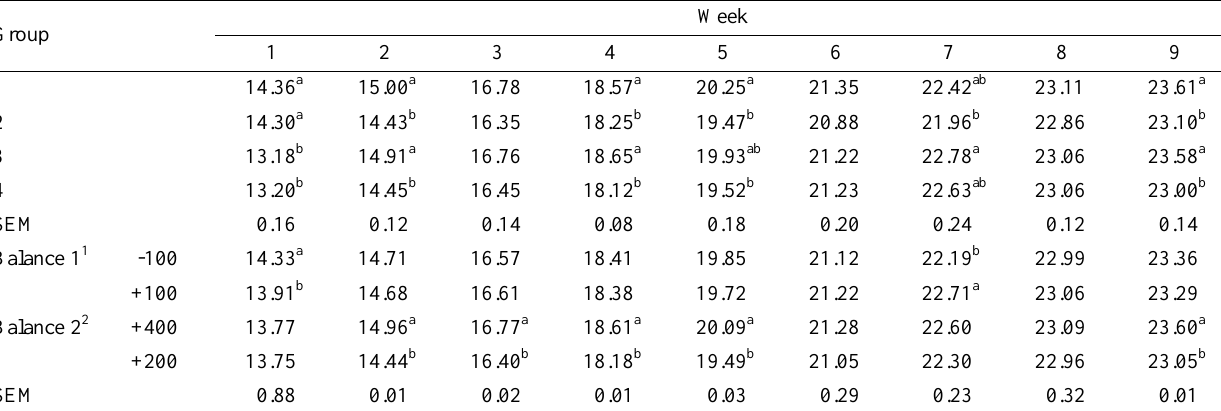
Table 7. The effect of dietary cation-anion difference on dry matter intake in postpartum period Group